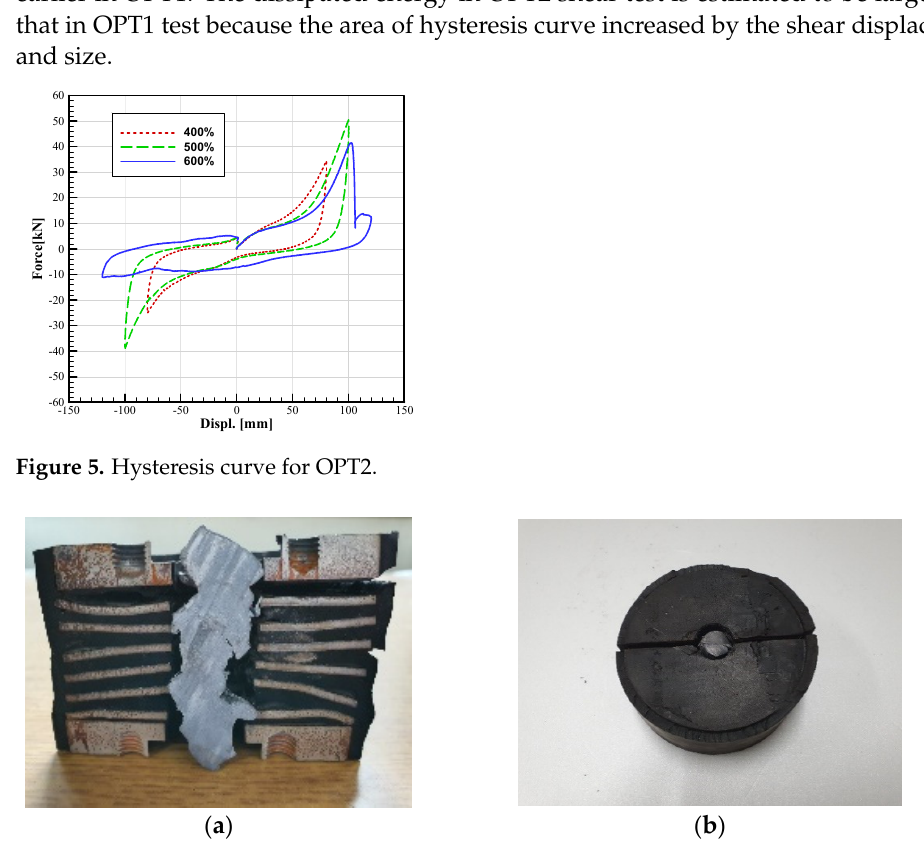
Figure 6. Section view of LRB after ultimate static test: ( a ) vertical section; ( b ) horizontal section.